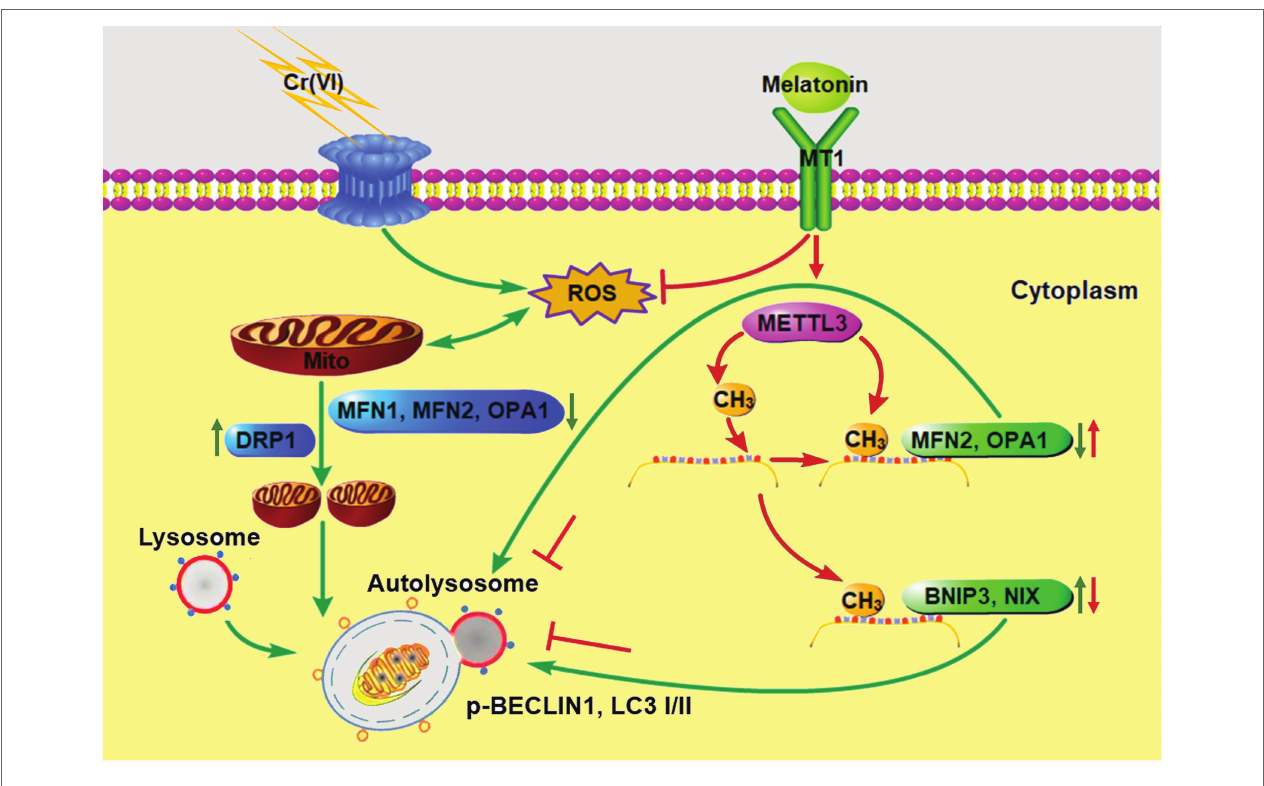
FIGURE 10 | A schematic overview illustrating melatonin-mediated attenuation of Cr (VI)-induced mitochondrial dynamic disorders and mitophagy in SSCs. Cr (VI) exposure induces ROS generation and oxidative stress, and downregulates mitochondrial fusion proteins MFN1, MFN2, and OPA1, while upregulates the mitochondrial fission protein DRP1, resulting in mitochondrial dynamic disorders. The fragmented mitochondria fuse with lysosomes to form autolysosomes, causing aberrant mitophagy. Melatonin can inhibit ROS production and restore METTL3-mediated RNA m 6 A modification levels in mitochondrial fusion genes Mfn2 and Opa1 , as well as in mitophagy genes Bnip3 and Nix , resulting in upregulation of MFN2 and OPA1 and downregulation of BNIP3 and NIX. In this way, autolysosomal formation and mitophagy are repressed. Green and red arrows point to Cr (VI)- and melatonin-induced biological processes,